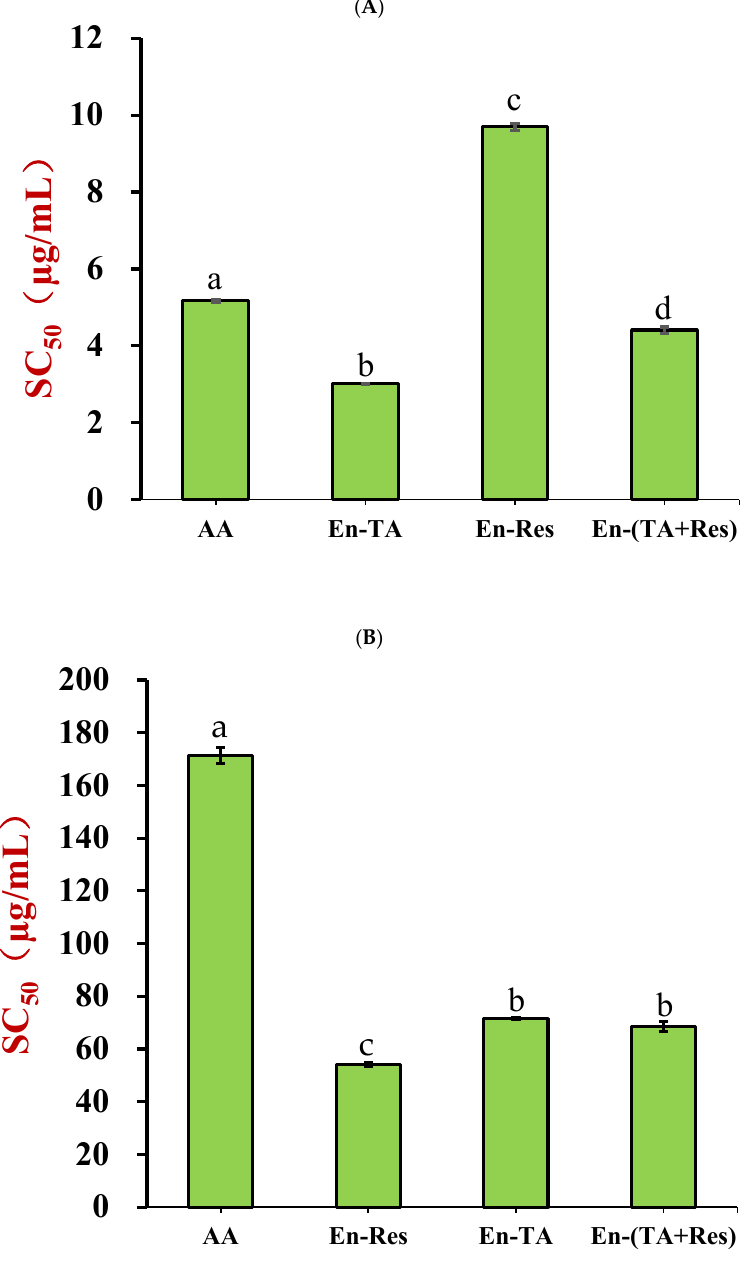
Figure 7. Comparison of the DPPH · ( A ) and ABTS + · ( B ) radical scavenging capacities (SC 50 values) of nanoparticle co-encapsulated tannic acid and resveratrol (En-(TA+Res)), nanoparticle encapsulated tannic acid (En-TA), nanoparticle encapsulated resveratrol (En-Res), and the physical mixture of tannic acid and resveratrol (PM-(TA+Res)) with the same composition with En-(TA+Res) (the letter “a–d” represents a statistically significant difference between two groups, p < 0.05).